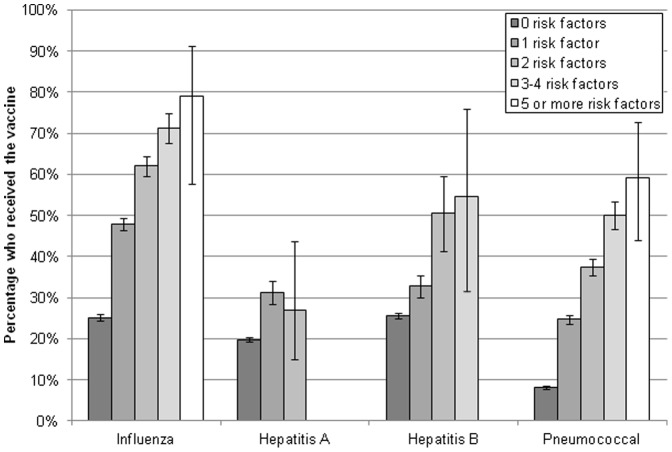
Vaccination rates by number of risk factors.